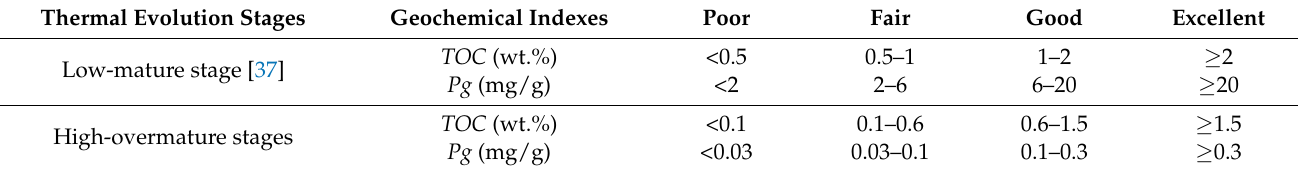
Table 4. Evaluation criteria for abundance of organic matter in mudstone of different maturity. Thermal Evolution